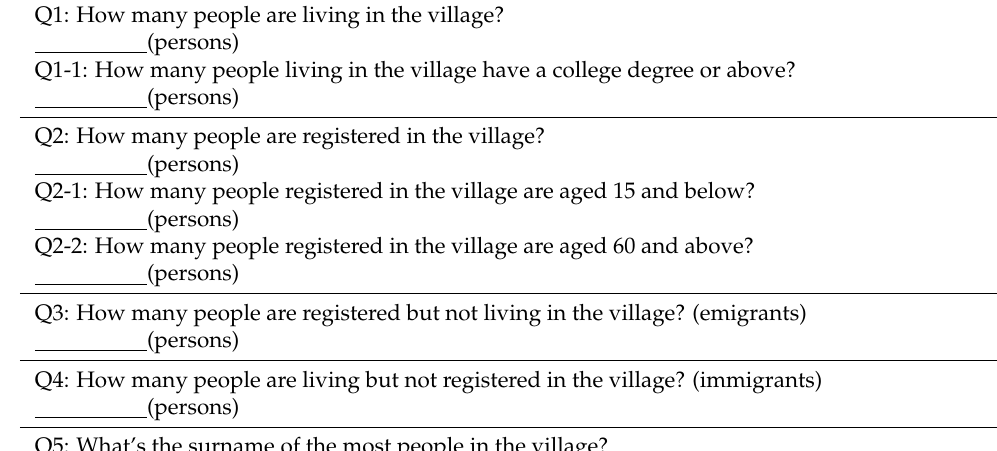
Table A1. Main Questions in the Village